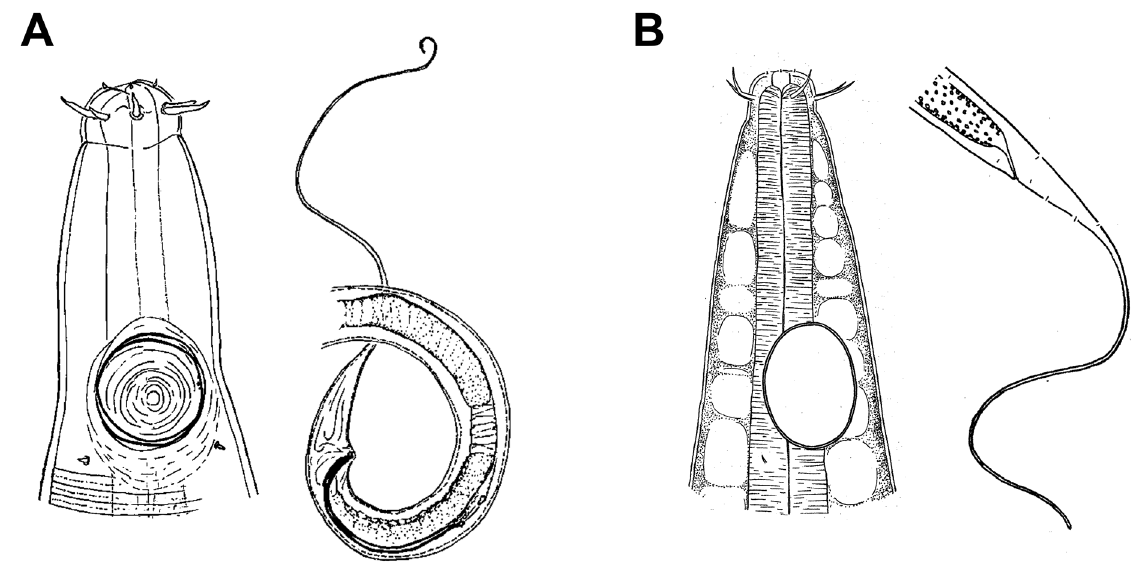
Fig. 2. Anterior and posterior body regions. A . Simpliconema aenigmatodes Blome & Schrage, 1985. B . Marisalbinema galtsovae Tchesunov, 1990. Drawings modified from Blome & Schrage (1985) and Tchesunov